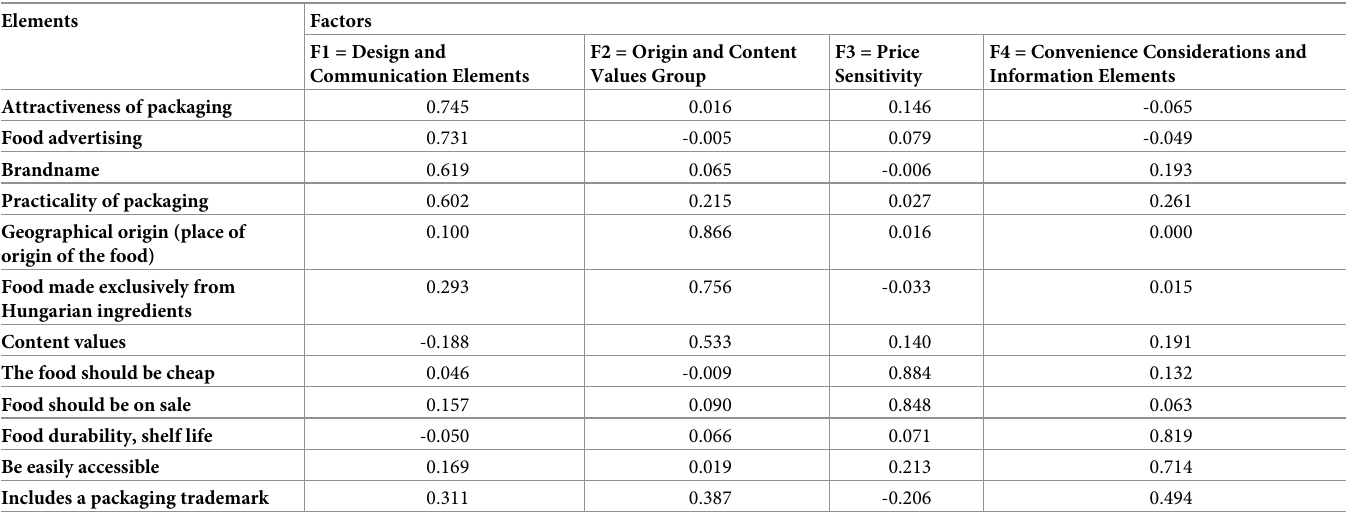
Table 2. Factor matrix of preference list in the case of food purchase.